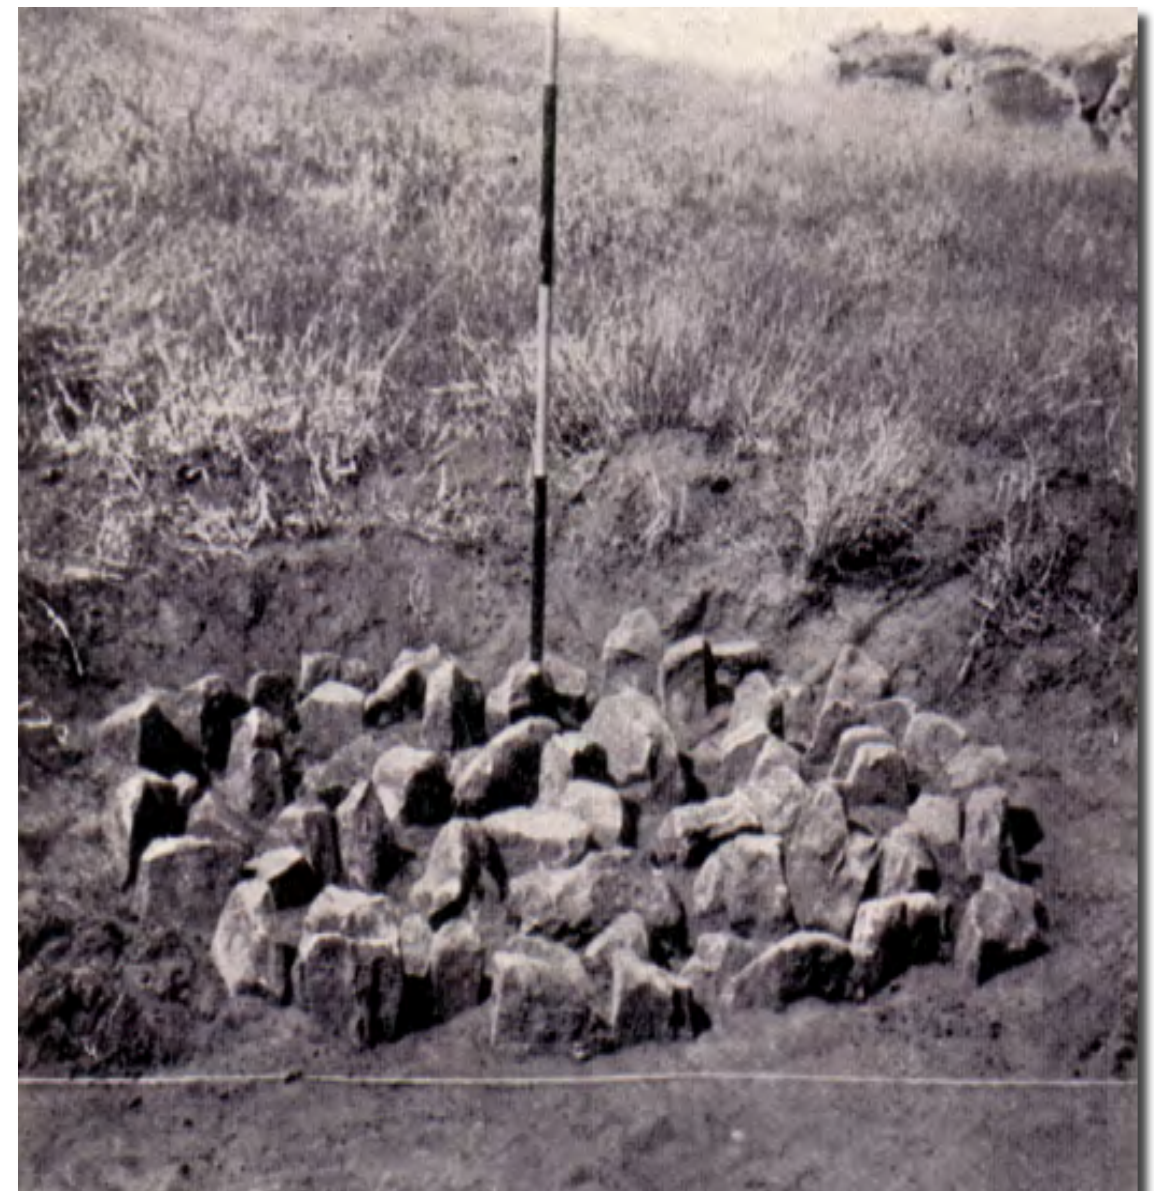
Figure 8. Stone circle observed and exposed on Mapungubwe Hill in 1933 (Fouché 1937:Plate